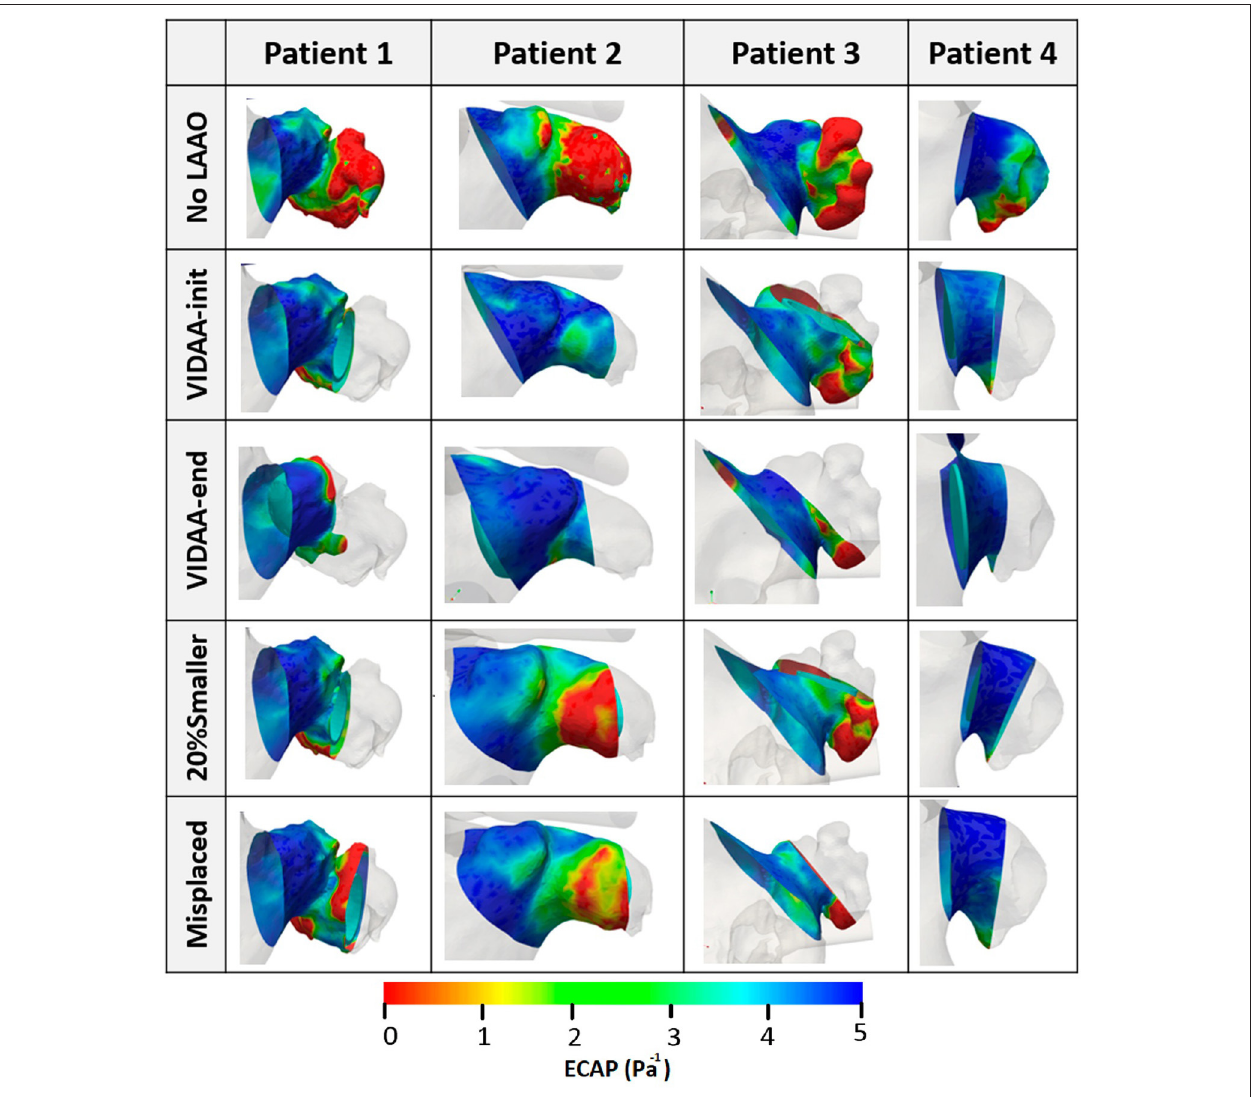
FIGURE 7 | Endothelial Cell Activation Potential (ECAP) distribution (Pa − 1 ) visualized as colored maps superimposed to the LA wall for the four patients under study. No LAAO: without device; VIDAA-init: device settings from morphological analysis and clinical recommendations; VIDAA-end: device settings after interactive manipulation in VIDAA; 20% smaller: device with a 20% smaller size than VIDAA-init; Misplaced: device with sub-optimal position and